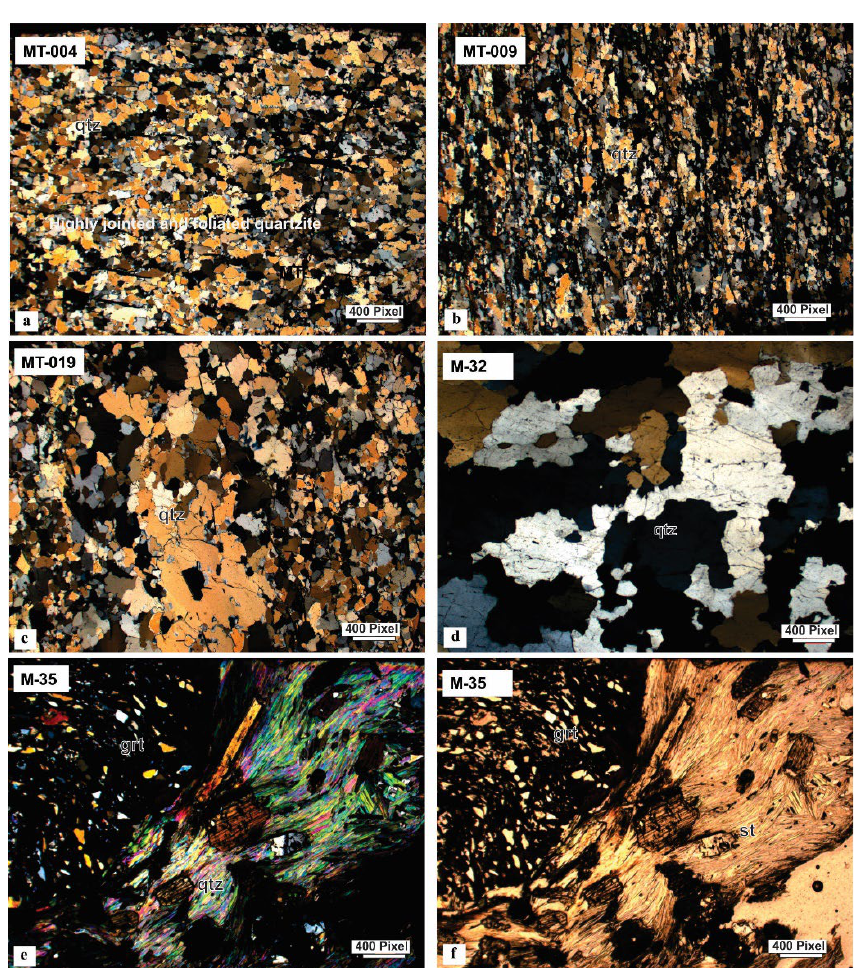
Figure 3. Selected photomicrographs of quartzite samples showing irregular, elongated grains of quartz ( a – d ), and garnet–staurolite schist samples showing graphite strings and minor biotite